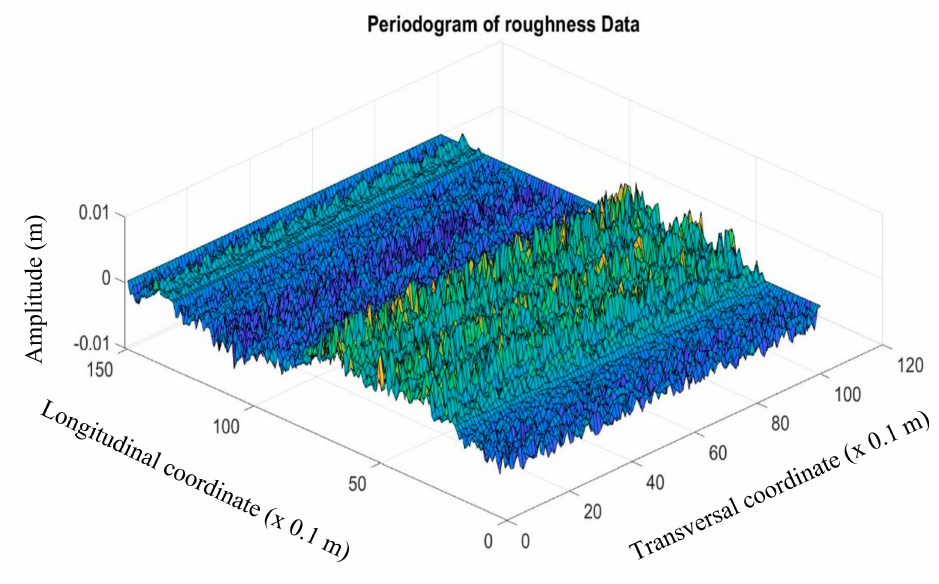
Figure 18. Class B road roughness generated.